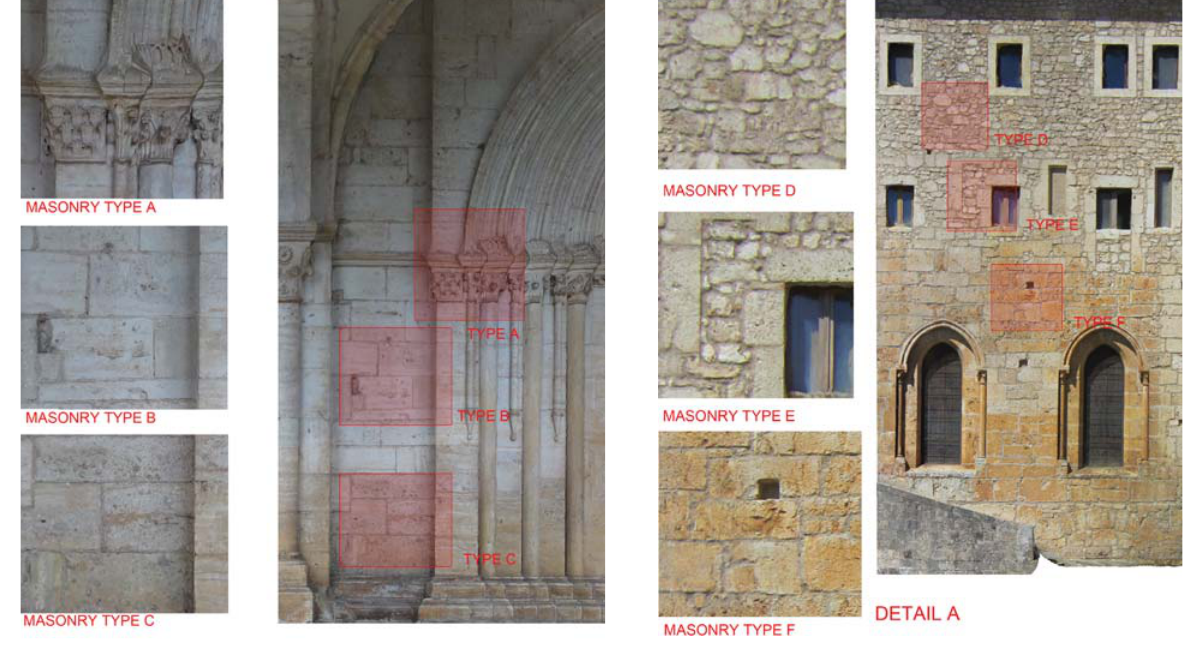
Figure 3a. Masonry Type of the Church Figure 3b. Masonry Type of the East Façade of the